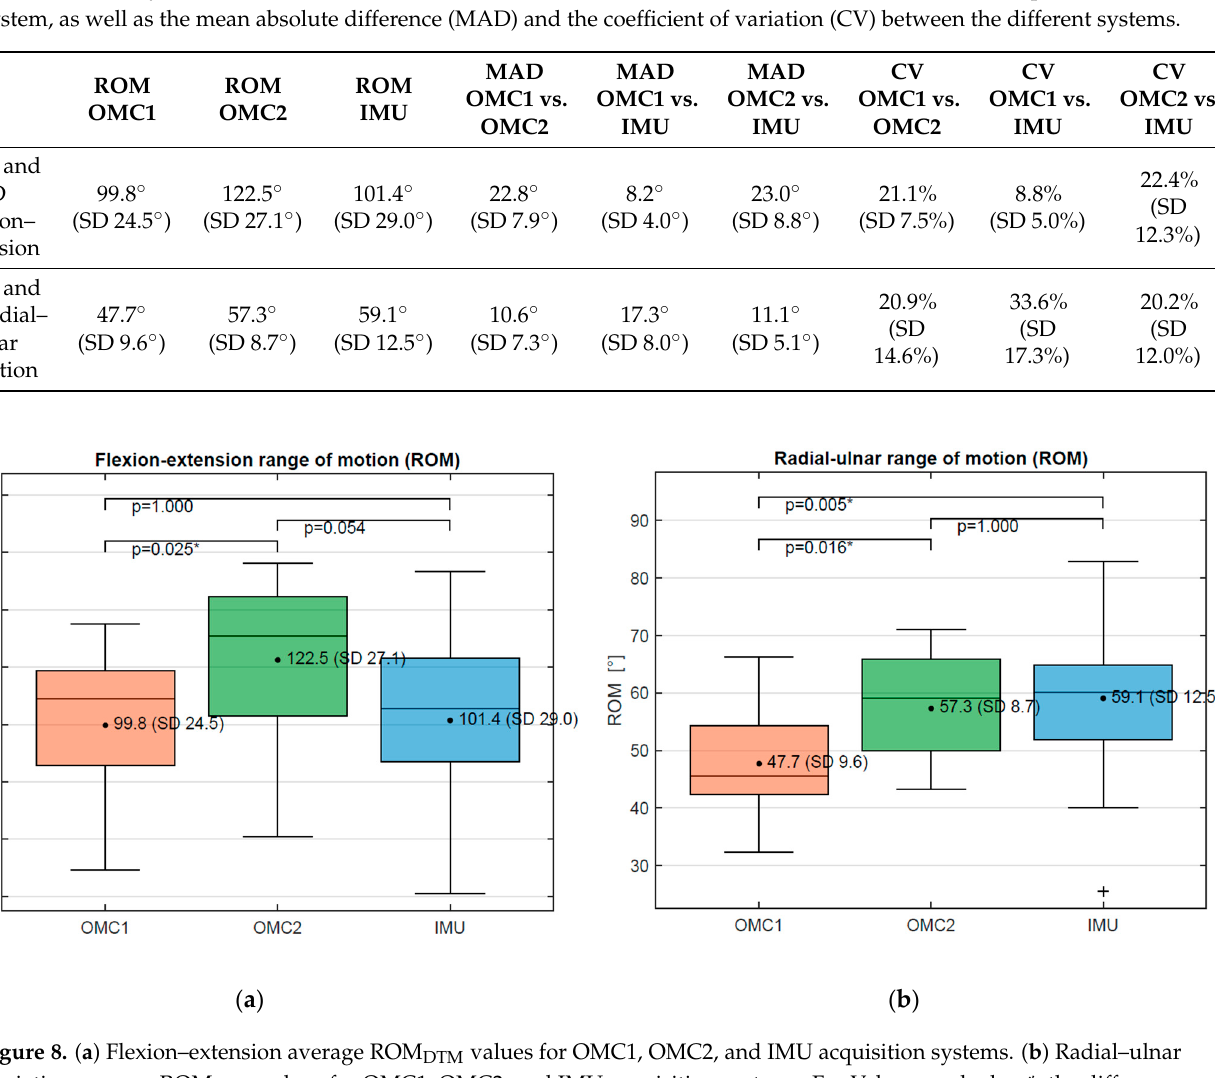
Figure 8. ( a ) Flexion–extension average ROM DTM values for OMC1, OMC2, and IMU acquisition systems. ( b ) Radial–ulnar deviation average ROM DTM values for OMC1, OMC2, and IMU acquisition systems. For Values marked as *, the difference is statistically